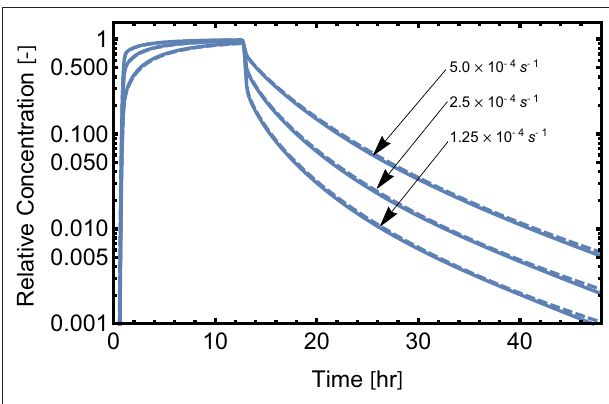
FIGURE 3 | Channel concentration at 3km relative to the inlet concentration for a conservative tracer test for three values of α , the hyporheic exchange rate constant. The solid curves are for the ADELS model and the dashed curves are for the